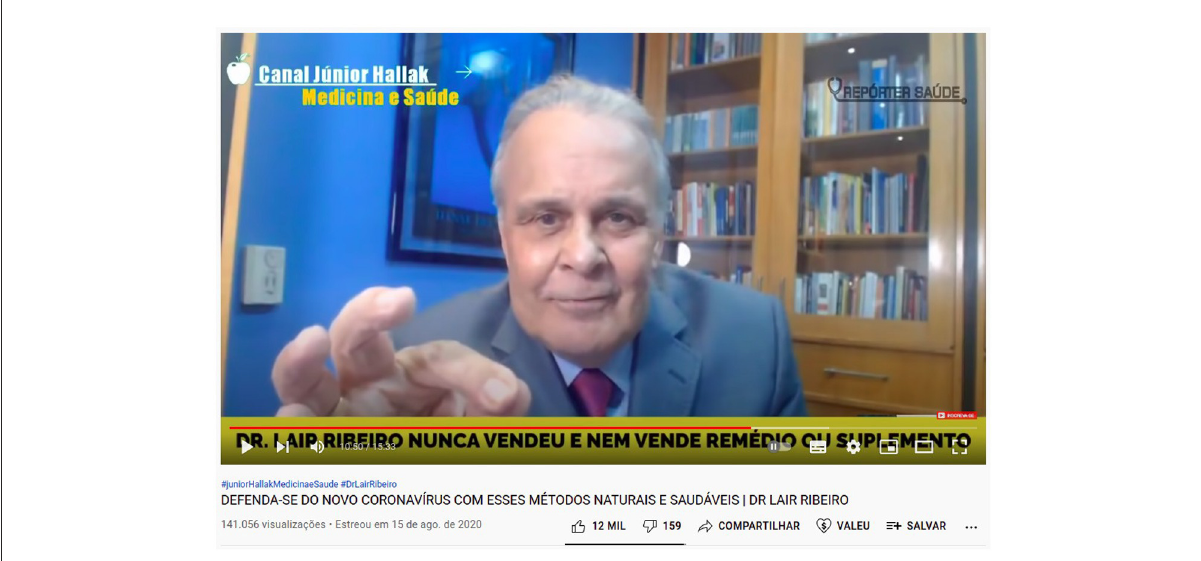
FIGURE8 Screenshot of the channel Junior Hallak Medicina e Saúde with the feature “Super Thanks” (“Valeu demais”). The feature is seen as the heart with a dollar sign inside it, and the word “VALEU” on its right. Video title: “Protect yourself from the new Coronavirus with these natural and healthy